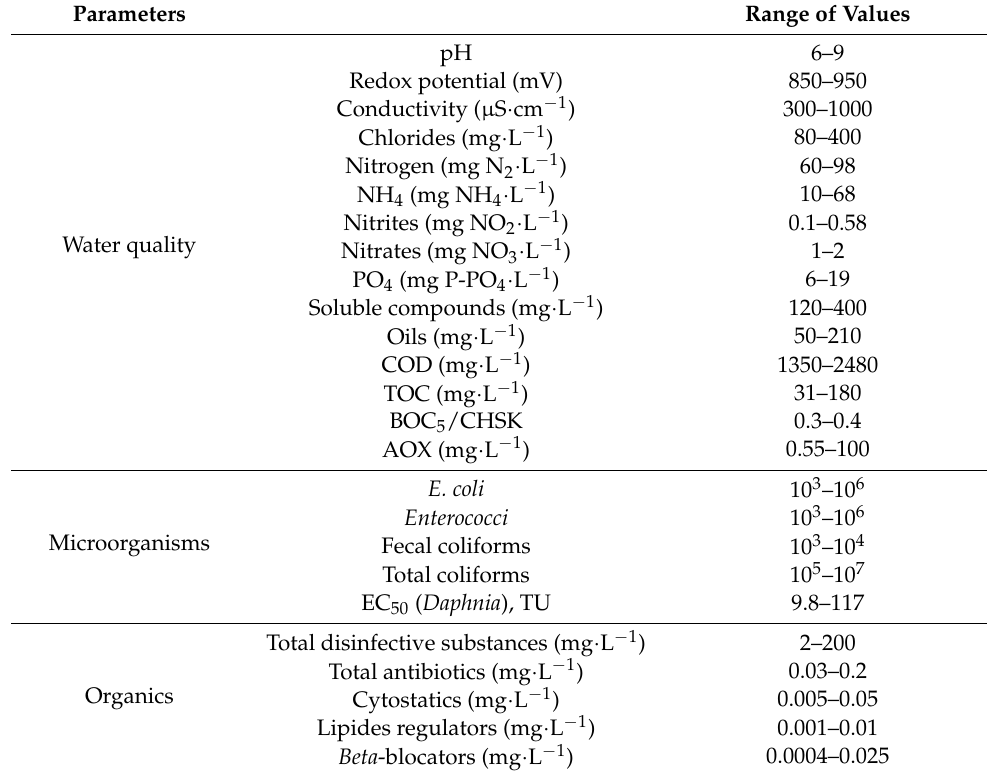
Table 1. Basic parameters of wastewater from hospitals and healthcare facilities